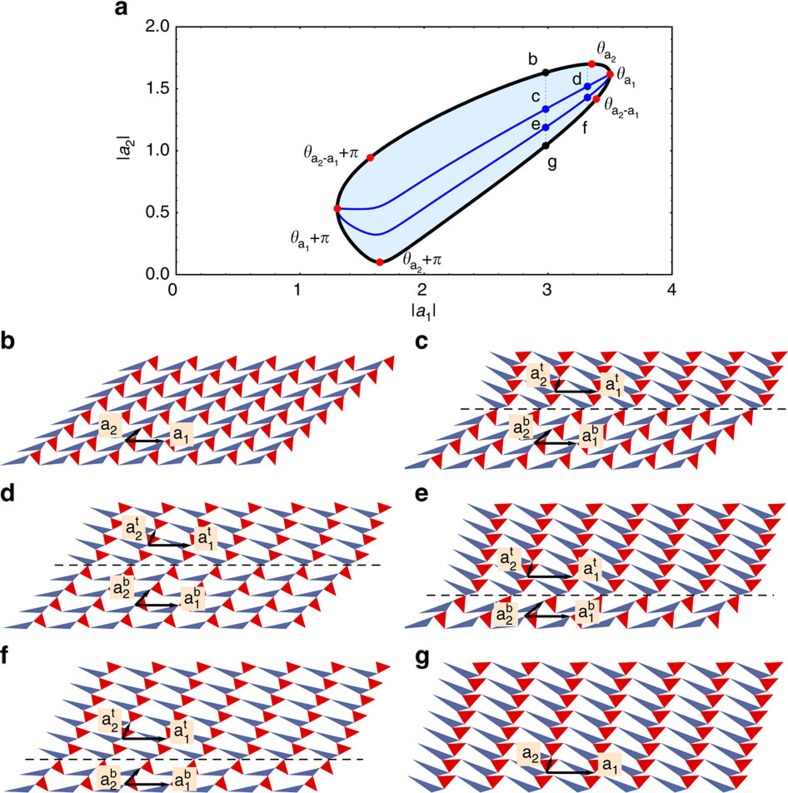
Transformation-induced domain structure.The nonlinear uniform soft twisting of a deformed kagome lattice alters the lengths of the two lattice vectors a1, a2 as indicated by the thick black curve of a. However, as discussed in the main text, at critical angles such as  it is possible to create distinct domains within which two sections of the material undergo the uniform soft twisting depicted in Fig. 1 in opposite directions. This leads to a family of new twisting modes such as the blue lines shown. Choosing the proper domain structure allows any set of material strains in the shaded region. In configuration (c), the top and bottom domains correspond, respectively, to the uniform configurations (b,g), with continuity at the interface allowed by the common length of the primitive vector a2. Configuration (c) may be transformed into configuration (d) by the soft twisting, but to achieve either a uniform configuration or configurations (e,f), which have different distributions of domains, the material must pass through a critical angle.